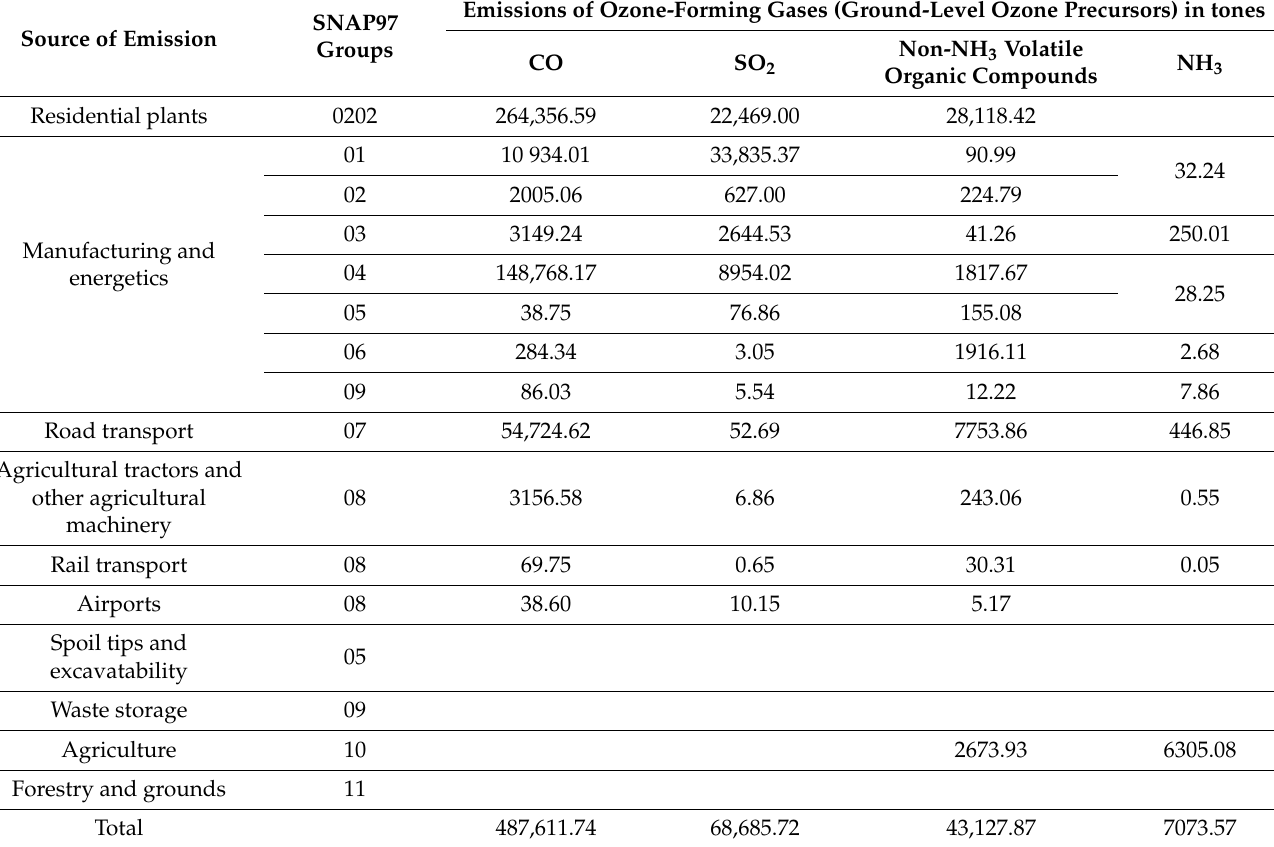
Table 9. Emission of ozone precursors in Silesian voivodships in 2018 based on